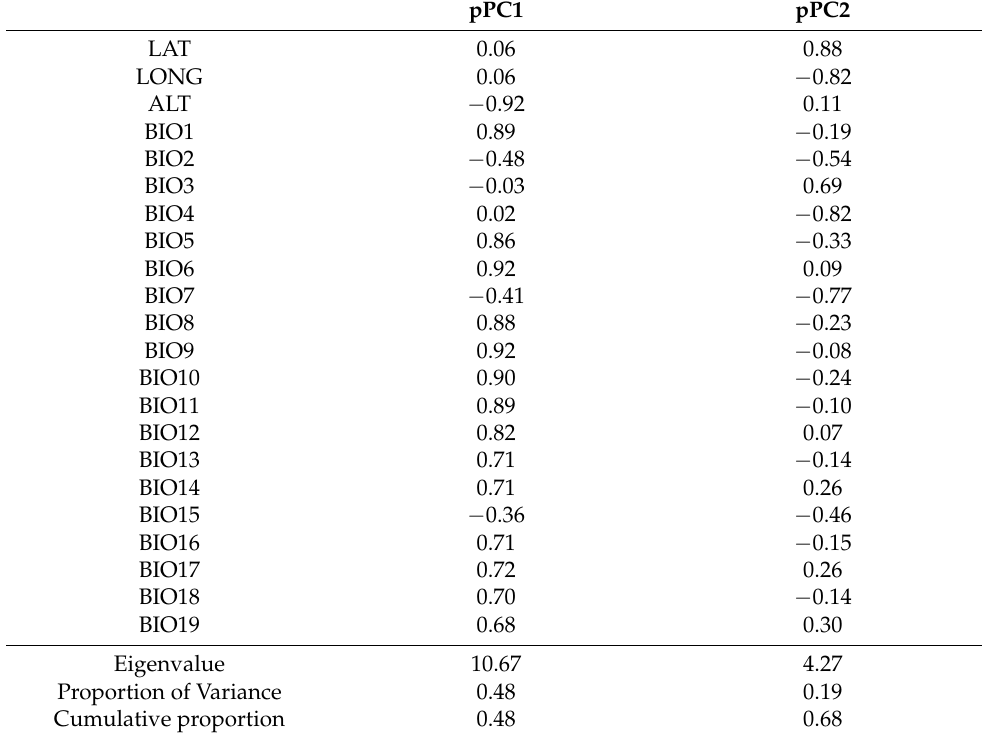
Table 2. Loadings, eigenvalues and variance explained by the two firsts principal components from an analysis of the 19 BioClim variables together with 3 geo-position variables for 62 Andean Macrocarpaea species. Results displayed are from the phylogenetic PCA based on the MCC tree. Variables are as follows: LAT = latitude, LONG = longitude, ALT = altitude, BIO1 = annual mean temperature; BIO2 = mean diurnal temperature range [mean of monthly (maximum temperature) minimum temperature)]; BIO3 = isothermality (BIO2/BIO7 × 100); BIO4 = temperature seasonal- ity (standard deviation of monthly temperature); BIO5 = maximum temperature of the warmest month; BIO6 = minimum temperature of the coldest month; BIO7 = temperature range (BIO6–BIO5); BIO8 = mean temperature of the wettest quarter; BIO9 = mean temperature of the driest quarter; BIO10 = mean temperature of the warmest quarter; BIO11 = mean temperature of the coldest quarter; BIO12 = annual precipitation; BIO13 = precipitation of the wettest month; BIO14 = precipitation of the driest month; BIO15 = precipitation seasonality (standard deviation of monthly precipita- tion); BIO16 = precipitation of the wettest quarter; BIO17 = precipitation of the driest quarter; BIO18 = precipitation of the warmest quarter; BIO19 = precipitation of the coldest